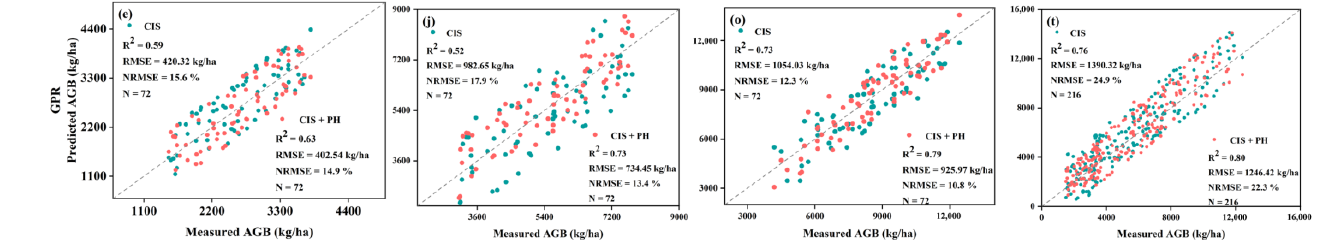
Figure 8. Relationships between the measured and the predicted AGB (kg/ha) based on CIS or CIS + PH using five regression models at different stages. Note: ( a – e ) jointing stage, ( f – j ) booting stage, ( k – o ) flowering stage, ( p – t ) all stages.